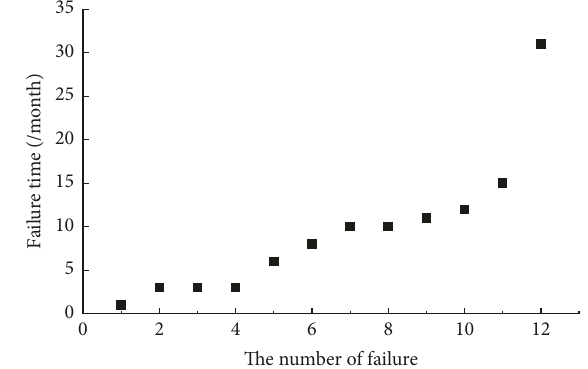
Figure 2: The historical data of the year 2007 of low-voltage